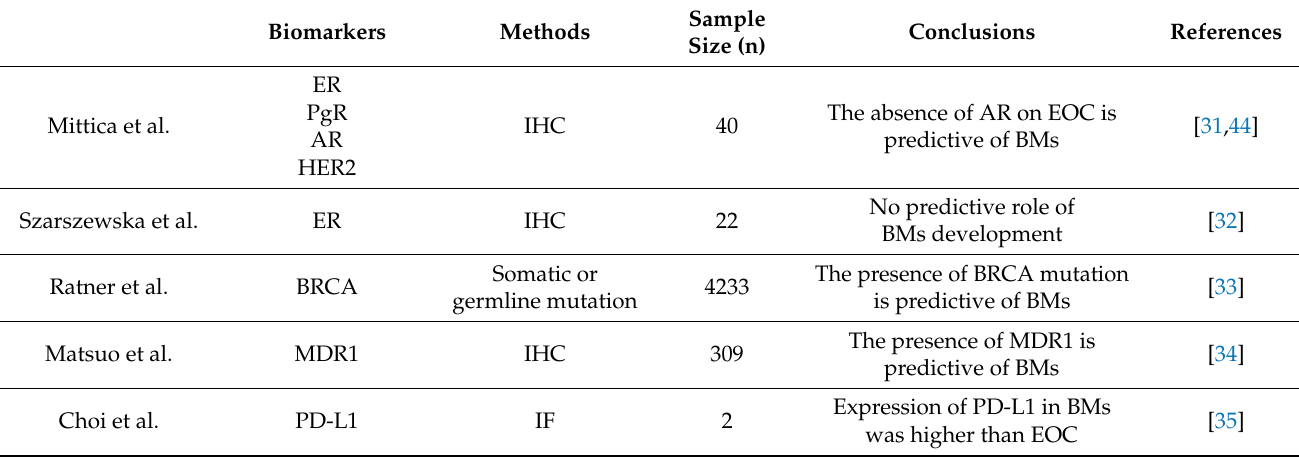
Table 2. Main studies that have evaluated the predictive role of biomarkers of BMs from ovarian cancer. Biomarkers